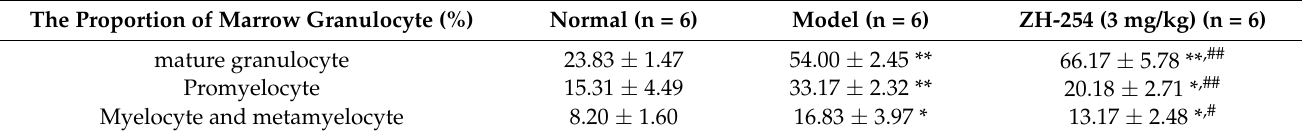
Table 2. The proportion of bone marrow granulocyte of F-MuLV-induced erythroleukemia mice (%) (X ± S, n =